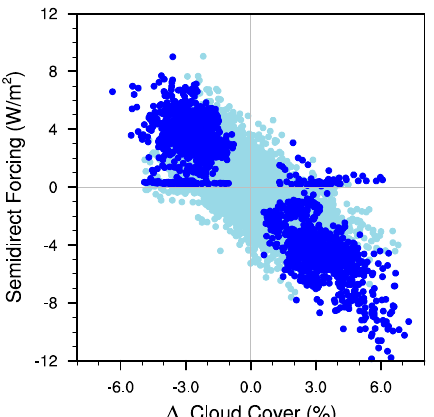
Figure 7. Scatterplot of model results of annual averaged BC TOA SDE in relation to cloud cover changes for the differences of the simulations noDUST and noABS. Results from model grid cells that are statistically significant at 95% levels are plotted in dark blue, results from grid cells with results with statistical significance below 95% are plotted in light blue.